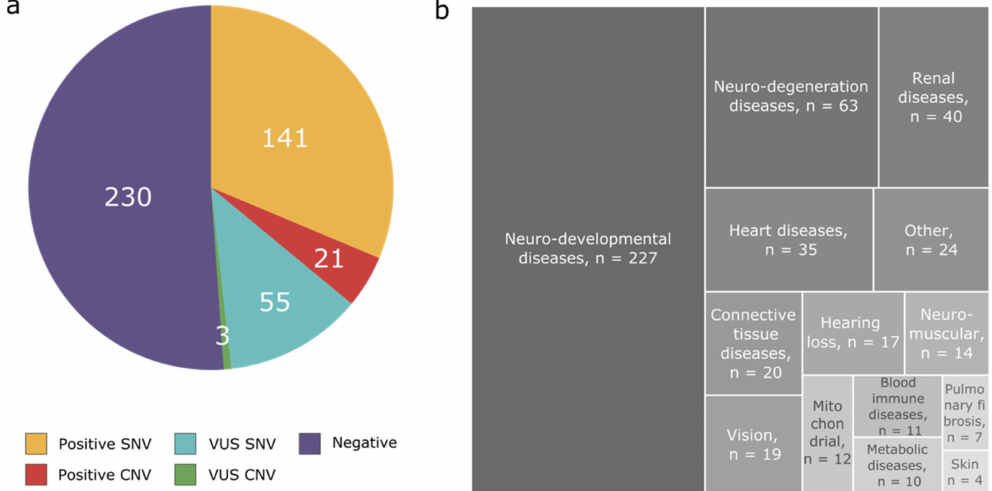
Figure 1. ( a ) Overall diagnostic yield in the 450 patients of the cohort–patient positive with compound heterozygous SNV and CNV affecting the same gene ( n = 1) is included in the category “Positive CNV” and ( b ) details of the disease categories for the